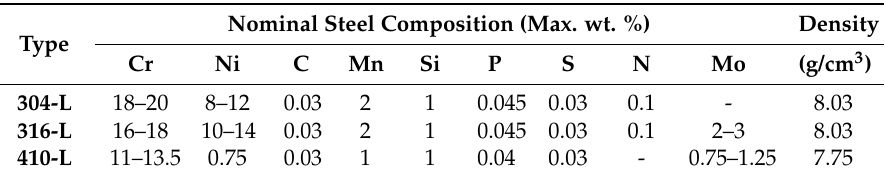
Table 1. Nominal manufacturer quoted compositions for the steel grades used in the present work; note that Fe comprises the balance in each case.